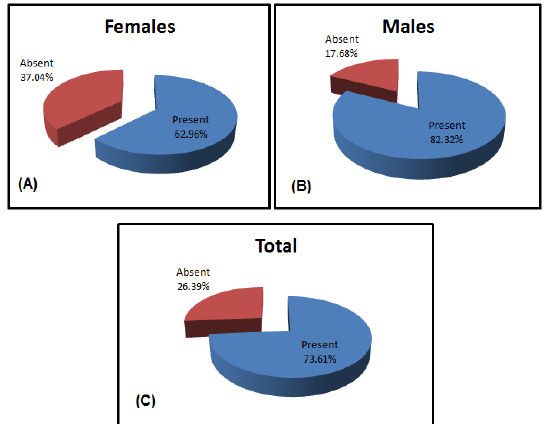
Figure 5: Radiographic prevalence of PSAA in relation to the gender. (A) for females, (B) for males and (C) for total sample.